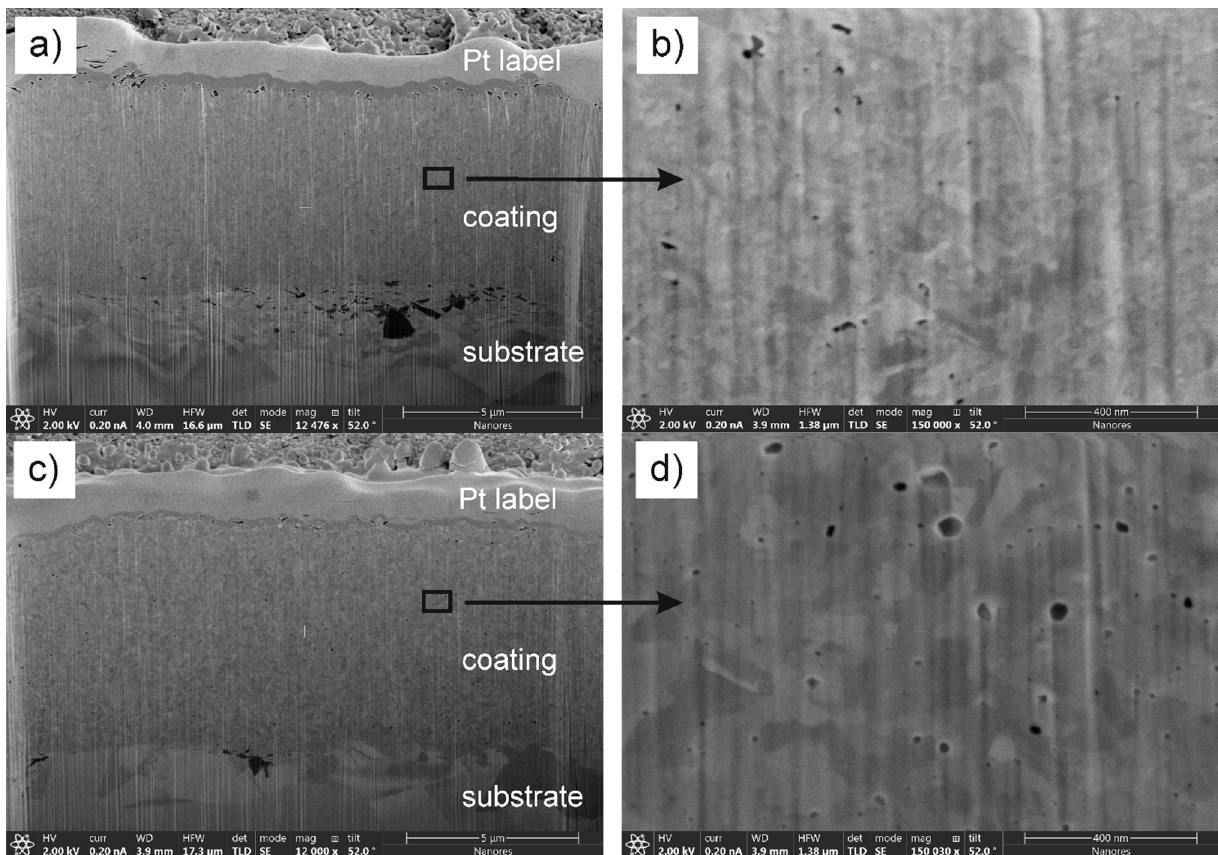
Figure 4. Coatings cross-sections demonstrating the microstructure at a micro- and nano-scale of Ni coatings before ( a , b ) and after ( c , d ) heat treatment at 300 °C for 2 h, deposited from ChCl: ethylene glycol DES containing 1 mol dm − 3 NiCl 2 ·6H 2 O (at 6 mA cm − 2 for 90 min at 70 °C).